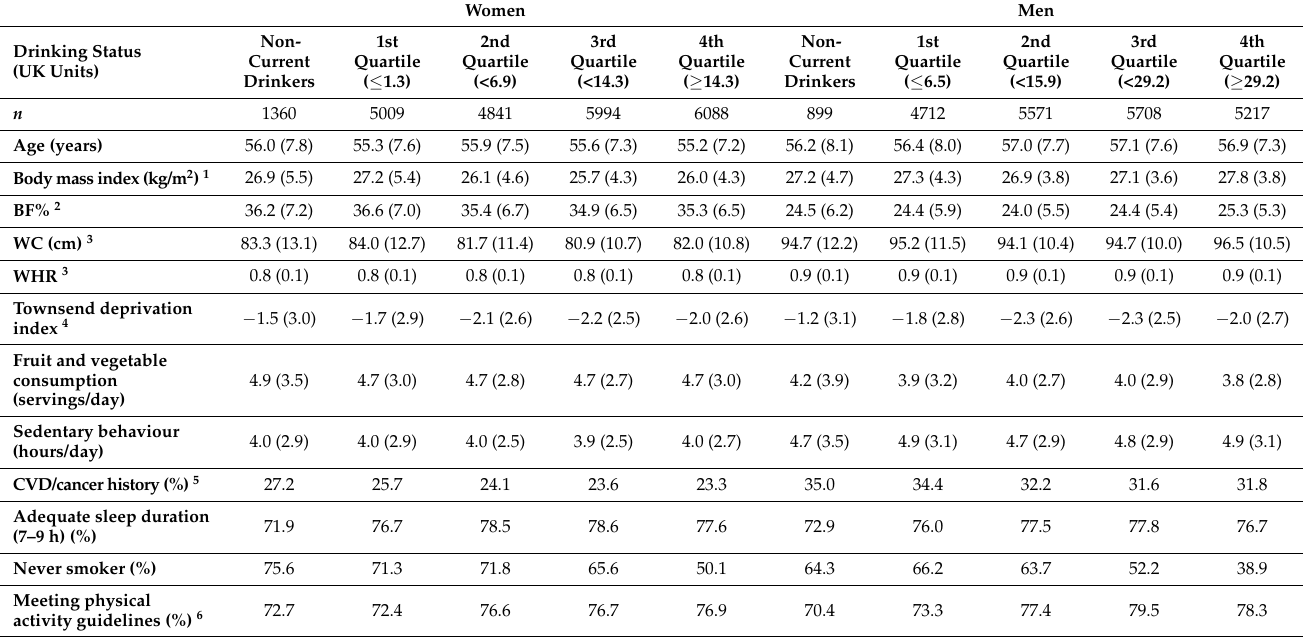
Table 1. Baseline characteristics of study sample by sex ( n = 45,399)